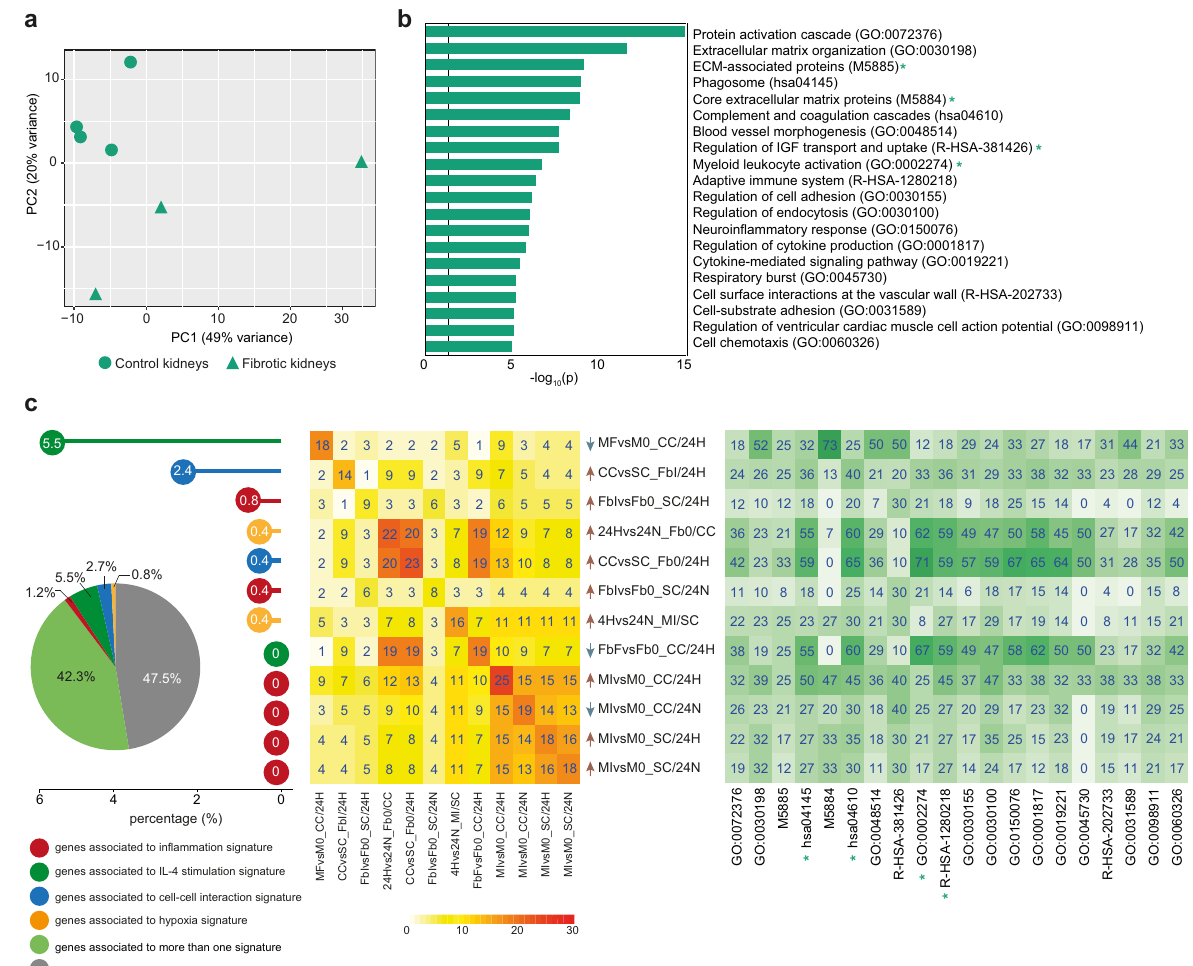
Fig. 9 | Gene overlap analysis of ex vivo glomeruli from fi brotic kidneys with in vitro signatures. a PCA of ex vivo glomerulisamples. Triangles indicate fi brotic kidneys, dots controlsamples. b Bargraphreportspathways signi fi cantlyenriched (log 10 ( p -value) ≥ 1.3) in fi brotic vs control glomeruli samples as calculated by Metascape software (for statistical type of analysis see ref.45). c Overlap analysis was performed comparing DEGs of ex vivo fi brotic vs control glomeruli with DEGs ofeachinvitrocomparison(whichde fi ned78correspondingsignatures).Piechart revealsthat42.3%ofexvivosignatureisexplainedbyatleastoneinvitrosignature (in light green); 10.2% is speci fi cally explained by only one in vitro signature and different colors are referred to the discriminating variable of in vitro signatures: in fl ammation in red, IL-4 stimulation in green, cell-cell interaction in blue, hypoxia inyellow.Theremaining47.5%oftheexvivoglomerulisignature(255genes)isnot explained by in vitro model (in gray). Dot chart reports on the vertical axis 12 in vitro signatures enriched in ex vivo model and their relative contribution with